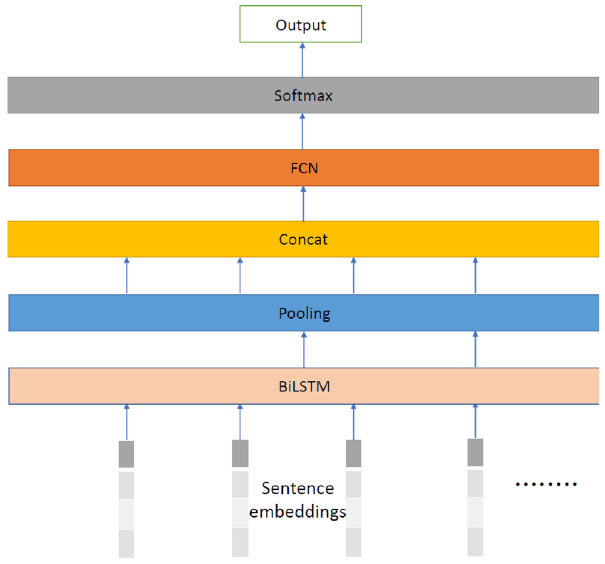
Fig. 1 Neural network overview. The input is a sequence of sentences extracted from an article, indicated by the grey columns at the bottom. The output is its sentiment score.